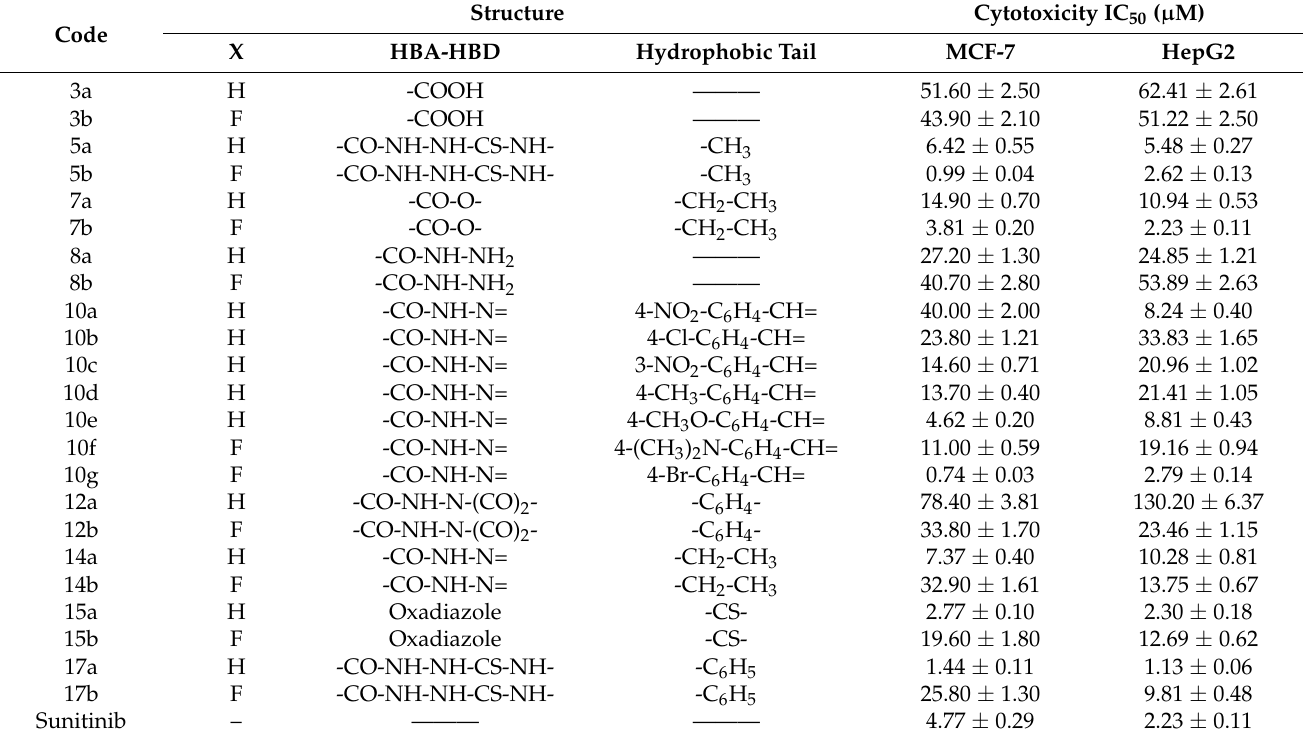
Table 1. Anti-proliferative activities of compounds 3a , b – 17a , b against the MCF-7 and HepG2 cell lines.